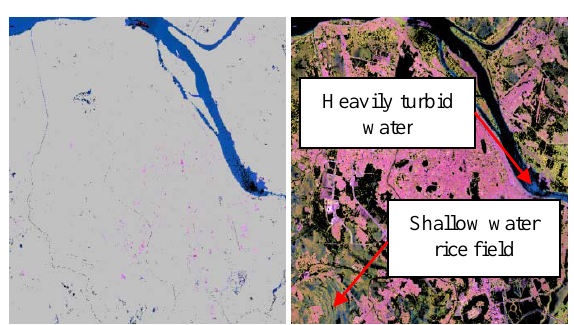
Figure 5. Modulation 00222 (left) and 002022 (right) for Spot 5